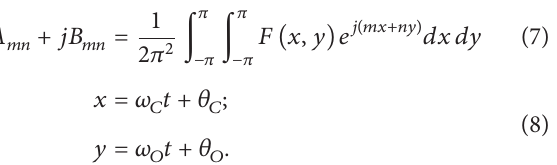
The first term in (6) represents the dc offset value, the second represents the fundamental and baseband harmonics, the third terms in the expression give the carrier harmonics, and the last term includes the carrier sideband harmonics, respectively